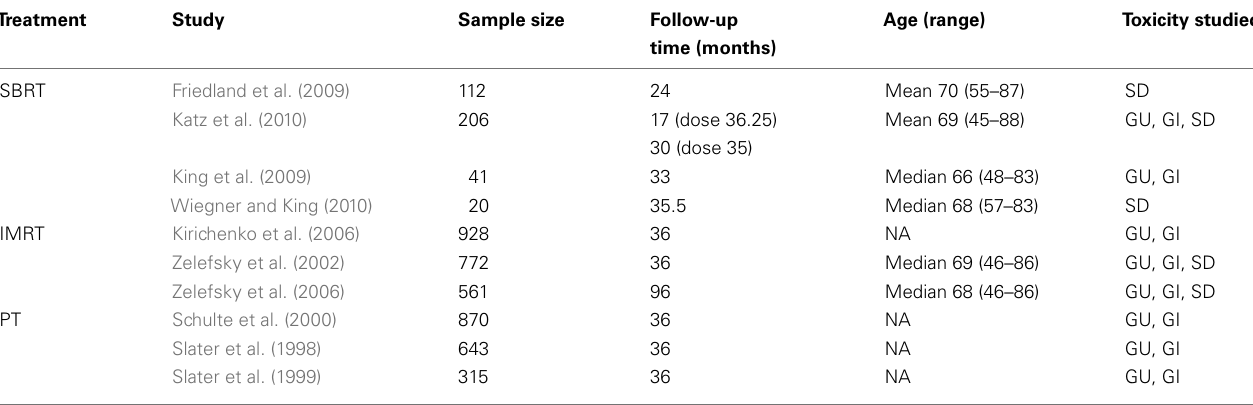
Table 1 | Characteristics of the 10 studies chosen for the meta-analysis.